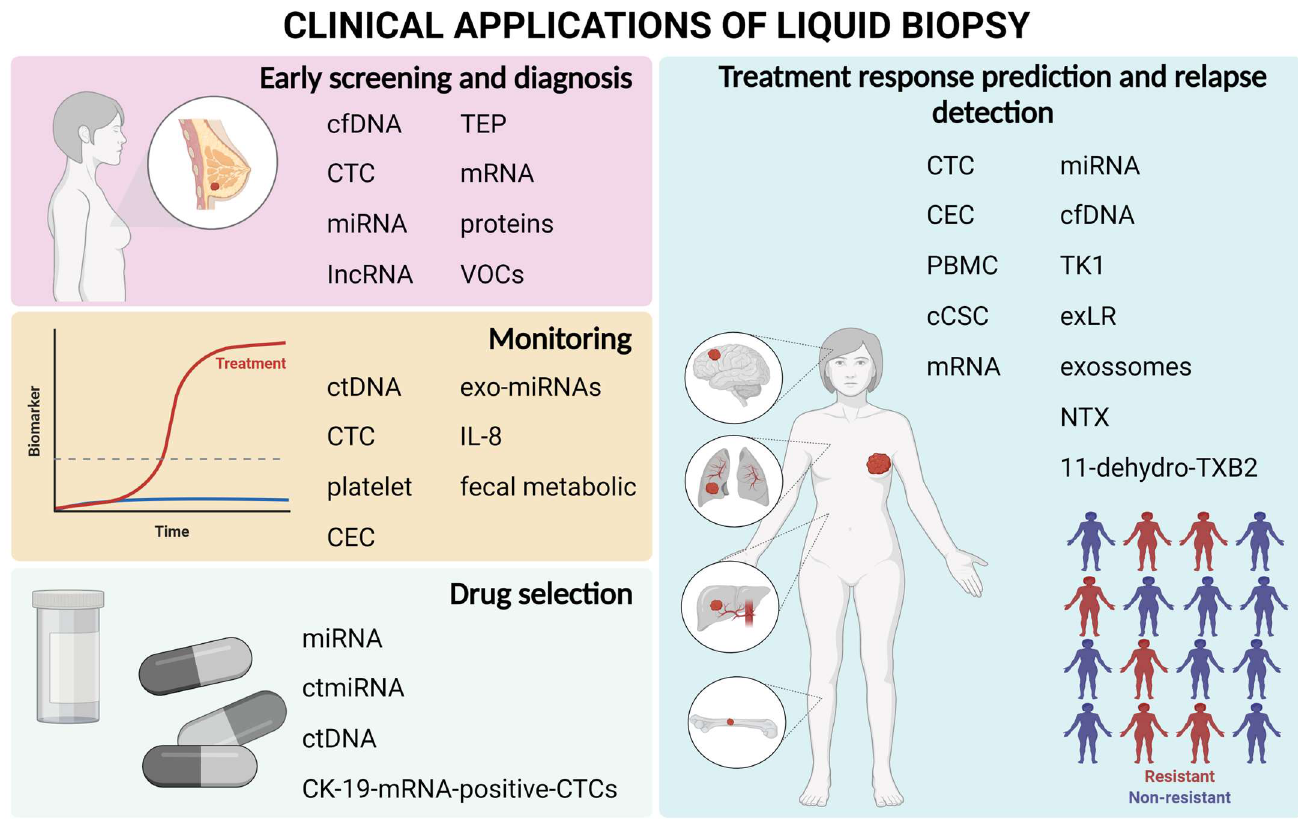
Figure 2. Main clinical uses of liquid biopsy with the biomarkers highlighted in the review.